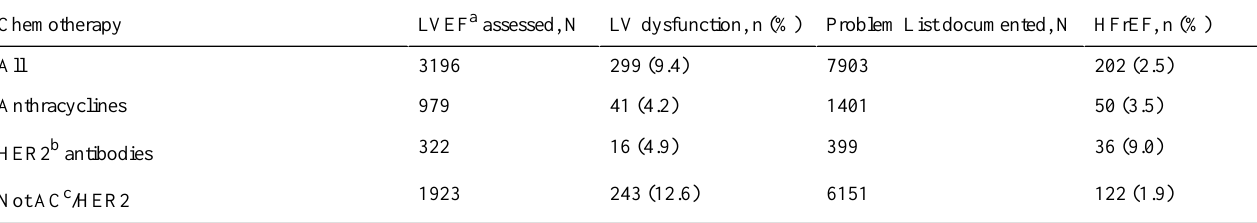
Table 3. Prevalence of left ventricular (LV) dysfunction and heart failure with reduced left ventricular ejection fraction (HFrEF) following